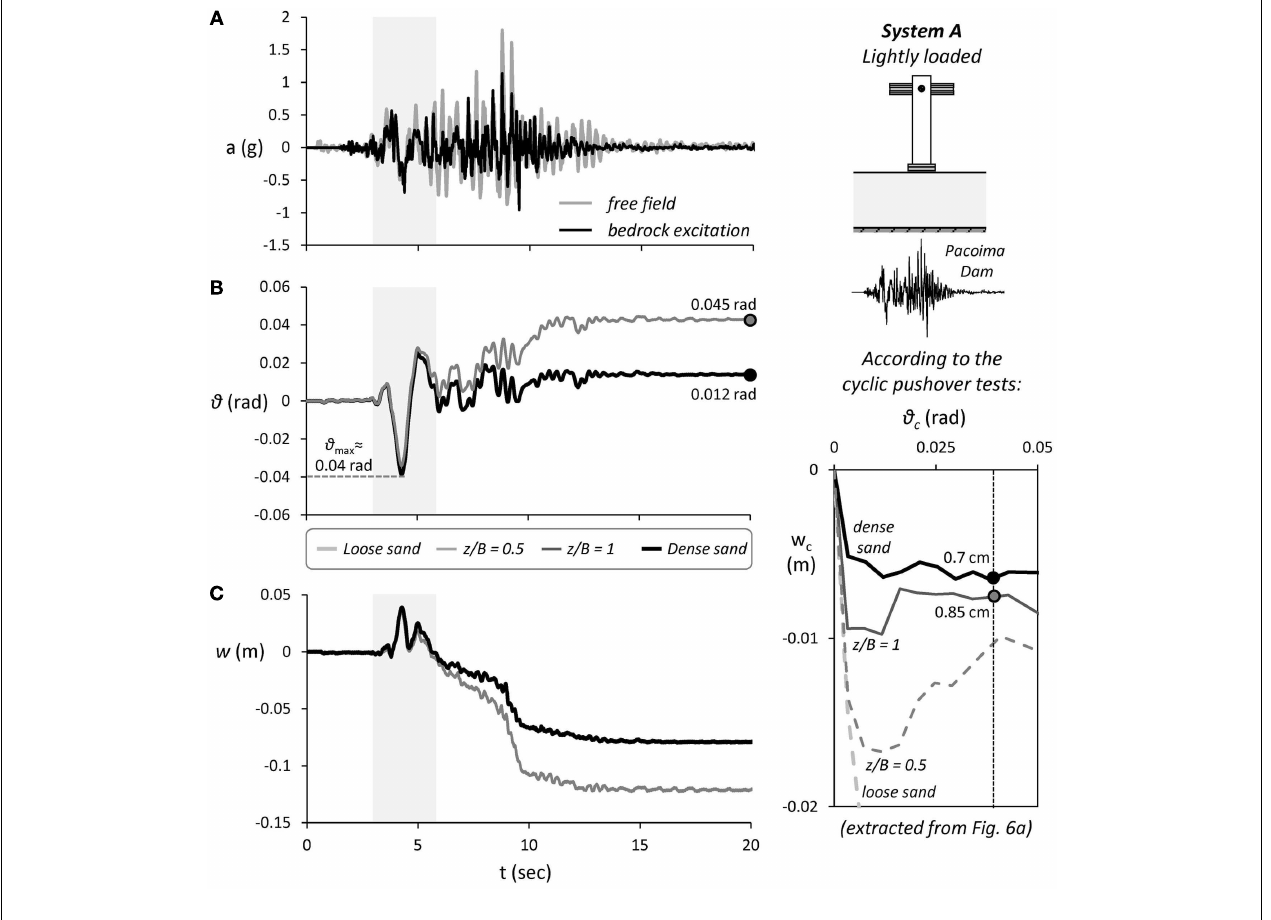
FIGURE 8 | Seismic performance of the lightly loaded System A subjected to seismic shaking using the Pacoima dam record as excitation–comparison of shallow soil improvement with poor (loose sand) and ideal (dense sand) soil conditions .